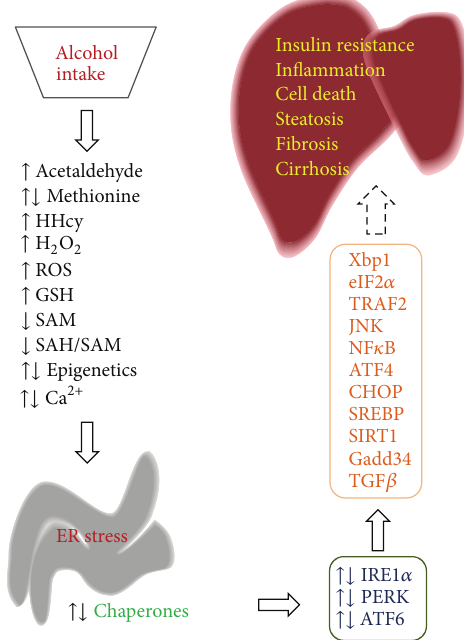
Figure 1: Identified molecular mechanisms for alcohol-induced endoplasmic reticulum stress and hepatic injuries. See the context for